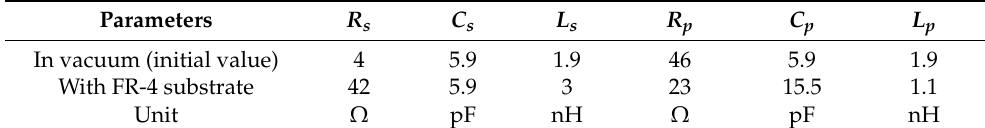
Table 2. Optimal component values of an equivalent circuit model of inverted an L-shaped planar monopole antenna on a partial ground plane in vacuum and with FR-4 substrate.